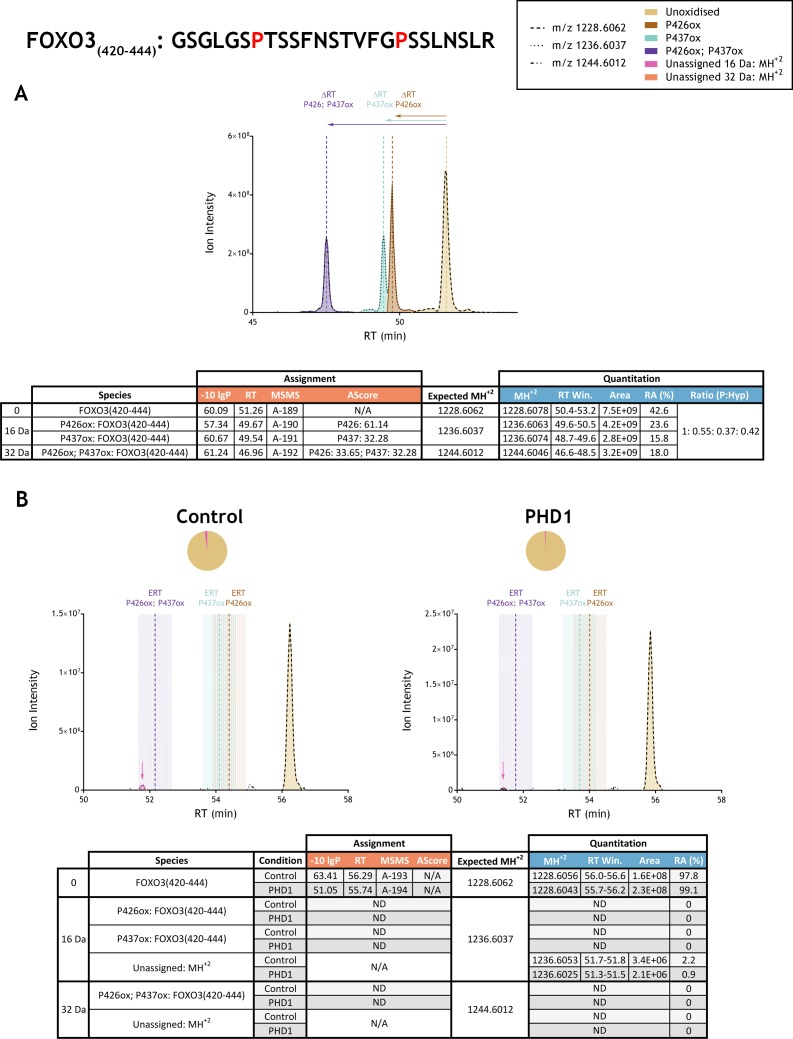
Quantitation of peptide oxidation on FOXO3(420–444) following reaction of full-length forkhead box O3 with recombinant PHD1.XIC data presented in (A) shows ion intensity and retention time (RT) characteristics of equimolar synthetic peptide standards for unoxidised and proline oxidised forms (P426ox, P437ox or combined) of the FOXO3(420–444) peptide. MSMS assigned species are coloured (see inset); vertical dashed lines define peak maxima used to derive ΔRT values for the different hydroxyproline-containing peptides. Note, the elution profiles of P426ox (brown) and P437ox (turquoise) ions overlap; area calculations were performed by vertical bisection of the valley between the co-eluting peaks to the baseline. Panel (B) shows comparable XIC data for protease-digested IVTT substrate under control (left) or PHD1-reacted (right) conditions. Peaks corresponding to unoxidised FOXO3(420–444) were detected in both control and enzyme reacted conditions; proline oxidation was not reported at any site. Estimated RT (ERT) values for proline oxidised peptides, derived from (A), are indicated by dashed vertical lines; shading corresponds to a 1 min RT window. Peptide ions of low abundance that were compatible with a single (+16 Da) oxidation event but not assigned by MSMS are indicated (pink arrow); unassigned ions with a compatible mass over charge for double oxidation (i.e.,+32 Da) were not observed across the elution window. Quantitative data for observed species are presented as pie charts with XIC data. Assignment and quantitation data are tabulated below each panel, table headers are as follows: (−10lgP) significance score of leading assignment at given (RT) with ambiguity score (AScore) for PTM localisation and reference to primary MSMS data in Supplementary file 1. Quantitative data reports ion counts (Area) of observed masses (MH+2) integrated over time (RT Win.), expressed as relative abundance (RA). Data on detection efficiency for synthetic peptides (Panel A, P: Hyp) is an aggregated ratio of prolyl (P) to hydroxyprolyl (Hyp) containing species.